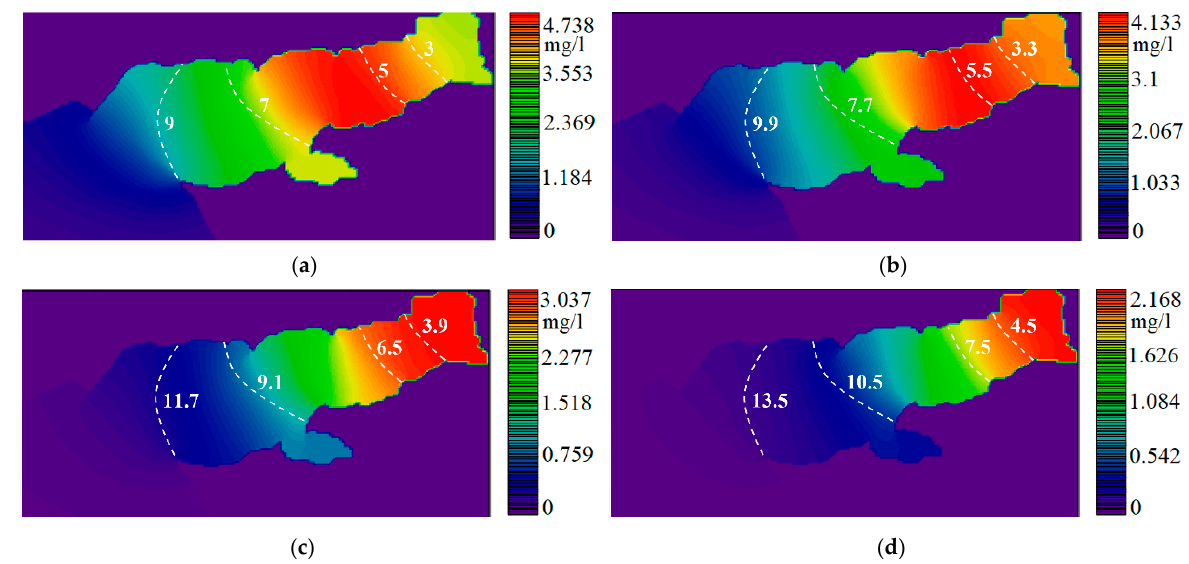
Figure 5. Distributions of blue-green algae ( Aphanizomenon flos-aquae ) concentrations at different salinity levels: ( a ) initial; ( b ) increased by 10%; ( c ) increased by 30%; ( d ) increased by 50%.